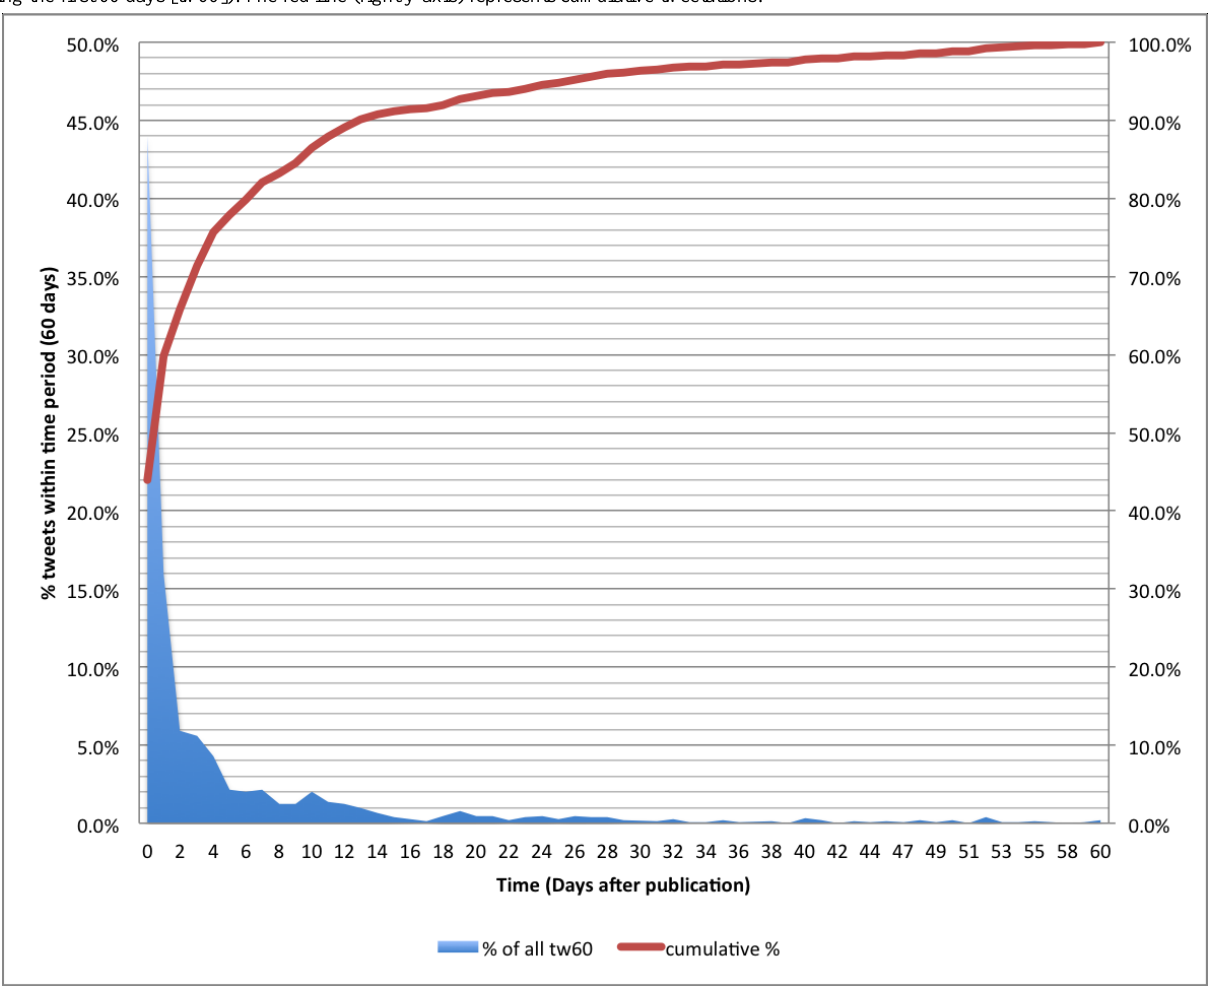
Figure 3. Tweetation dynamics. The blue, shaded area (left y-axis) shows the tweet rate (new tweetations per day, as a proportion of all tweetations during the first 60 days [tw60]). The red line (right y-axis) represents cumulative